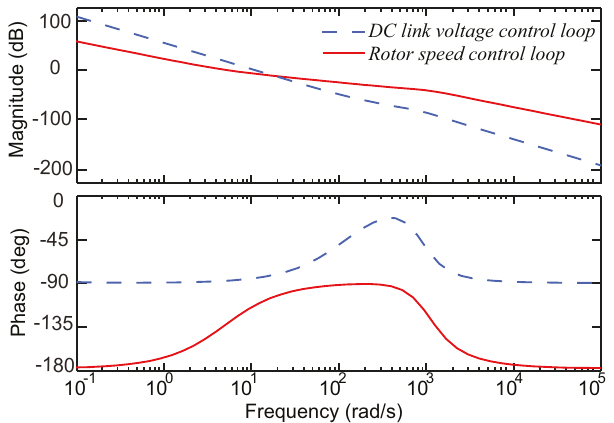
Figure 11. Bode diagram of the closed-loop WTG system with the proposed PI controller.